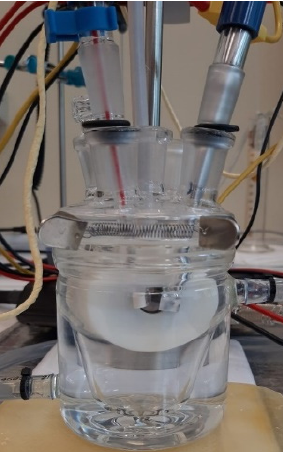
Figure 6. The electrochemical cell set-up used in the corrosion tests.